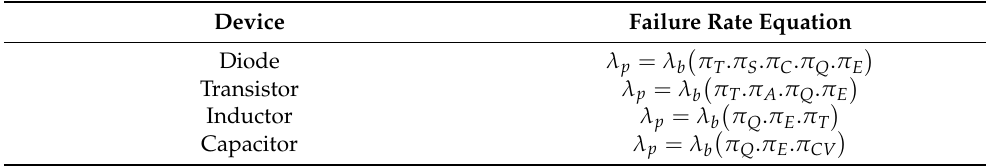
Table 1. Mathematical stress model for each component.